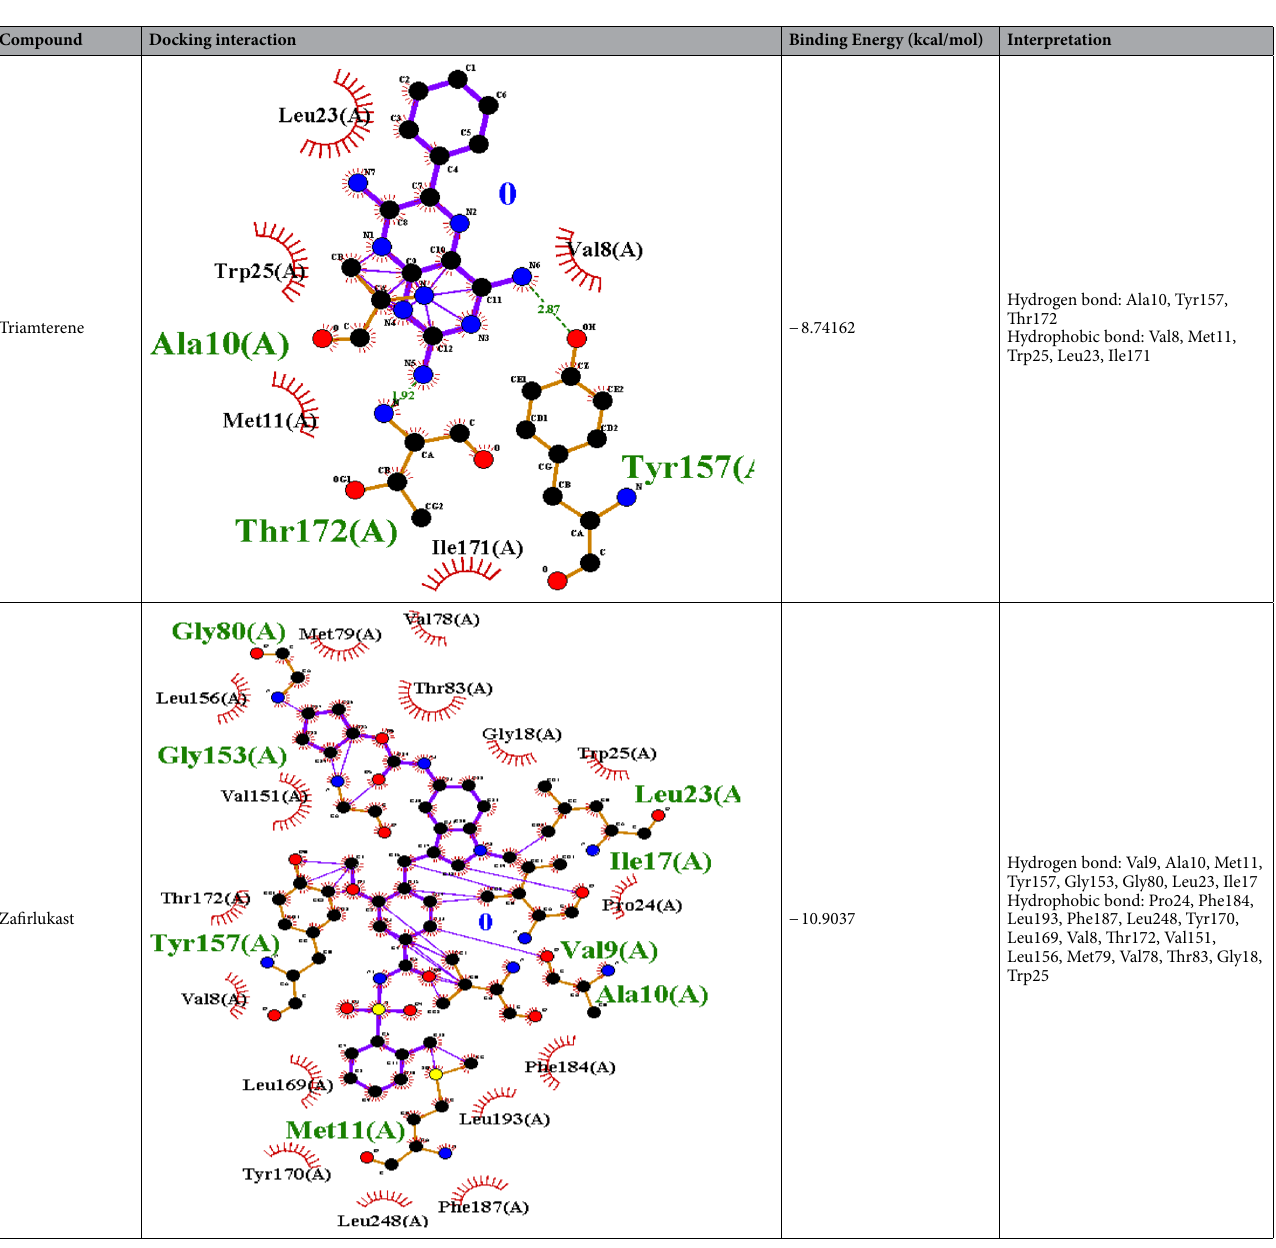
drugs against TgPRS protein with a structure similar to halofuginone compound that is TgPRS inhibitor. Our other criteria for the selection of drugs were low side effects and cost-effectiveness. For example, anticancer drugs that have many side effects were removed from our drug list, as well as expensive drugs. Evaluation of the interactions of different ligands in the active site of the TgPRS protein based on docking results showed that the Thr439, Arg470, His491, His560, Cys591, Gly590, Ala556, Ala557, and Trp487 residues present at the predicted active site of the TgPRS protein, and have a key role in the interaction of ligand–protein. 3D structural visualiza- tions of the drug–protein site interactions are shown in Fig. 2. Analysis of interactions of selected drugs with TgCDPK1. The binding energies of the selected FDA- approved drugs with the TgCDPK1 protein (PDB ID: 3SX9) were studied. The results of drug interactions with the protein were ranked based on affinity scores, interaction energies, number of bonds, and interaction of ligands with amino acid residues in the active site of the protein. In the first screening stage, we relied on the docking scores predicted by AutoDock Vina and ranked the top compounds. Drugs with lower affinity